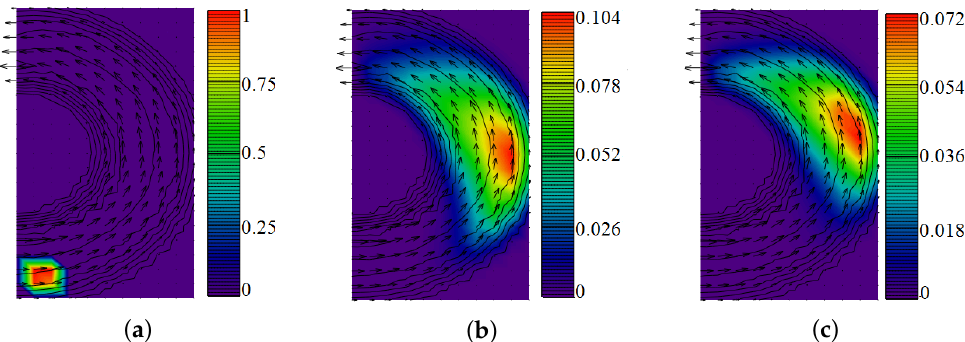
Figure 4. Numerical solution of the problem of the transfer of substances between two coaxial cylinders at small grid Péclet numbers: ( a ) the initial distribution of the concentration field; ( b ) and ( c ) the result of calculating the concentration field based on the difference scheme (15) and (19)–(22), respectively.